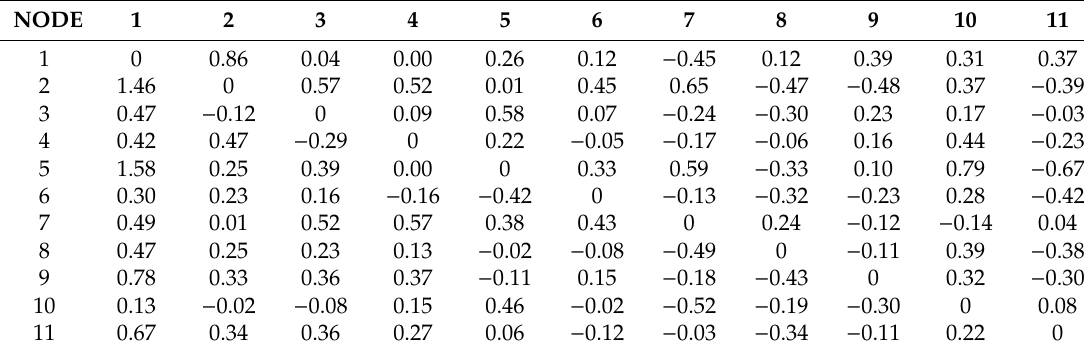
Table A6. Atletico Madrid’s individual Relative Out-Transition Entropy.